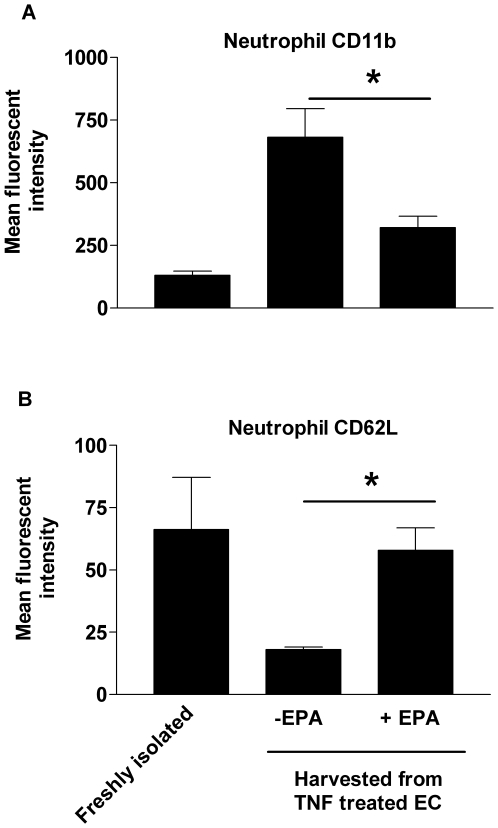
The effect of adhesion on the expression of l-selectin and CD11b on neutrophils.Neutrophils that were freshly isolated, migrated across endothelial cells stimulated with TNF or adherent to the surface of EPA-supplemented endothelial cells (EC) activated with TNF were harvested and the expression of (A) CD11b or (B) l-selectin (CD62L) assessed by flow cytometry. Data are mean±SEM of four experiments; ANOVA showed significant effect of treatments in (A) (p<0.01) and (B) (p<0.05). In (A and B), Dunnett's test showed significant difference between −EPA and freshly isolated cells (*p<0.01 and *p<0.05, respectively), but not between +EPA and freshly isolated cells.